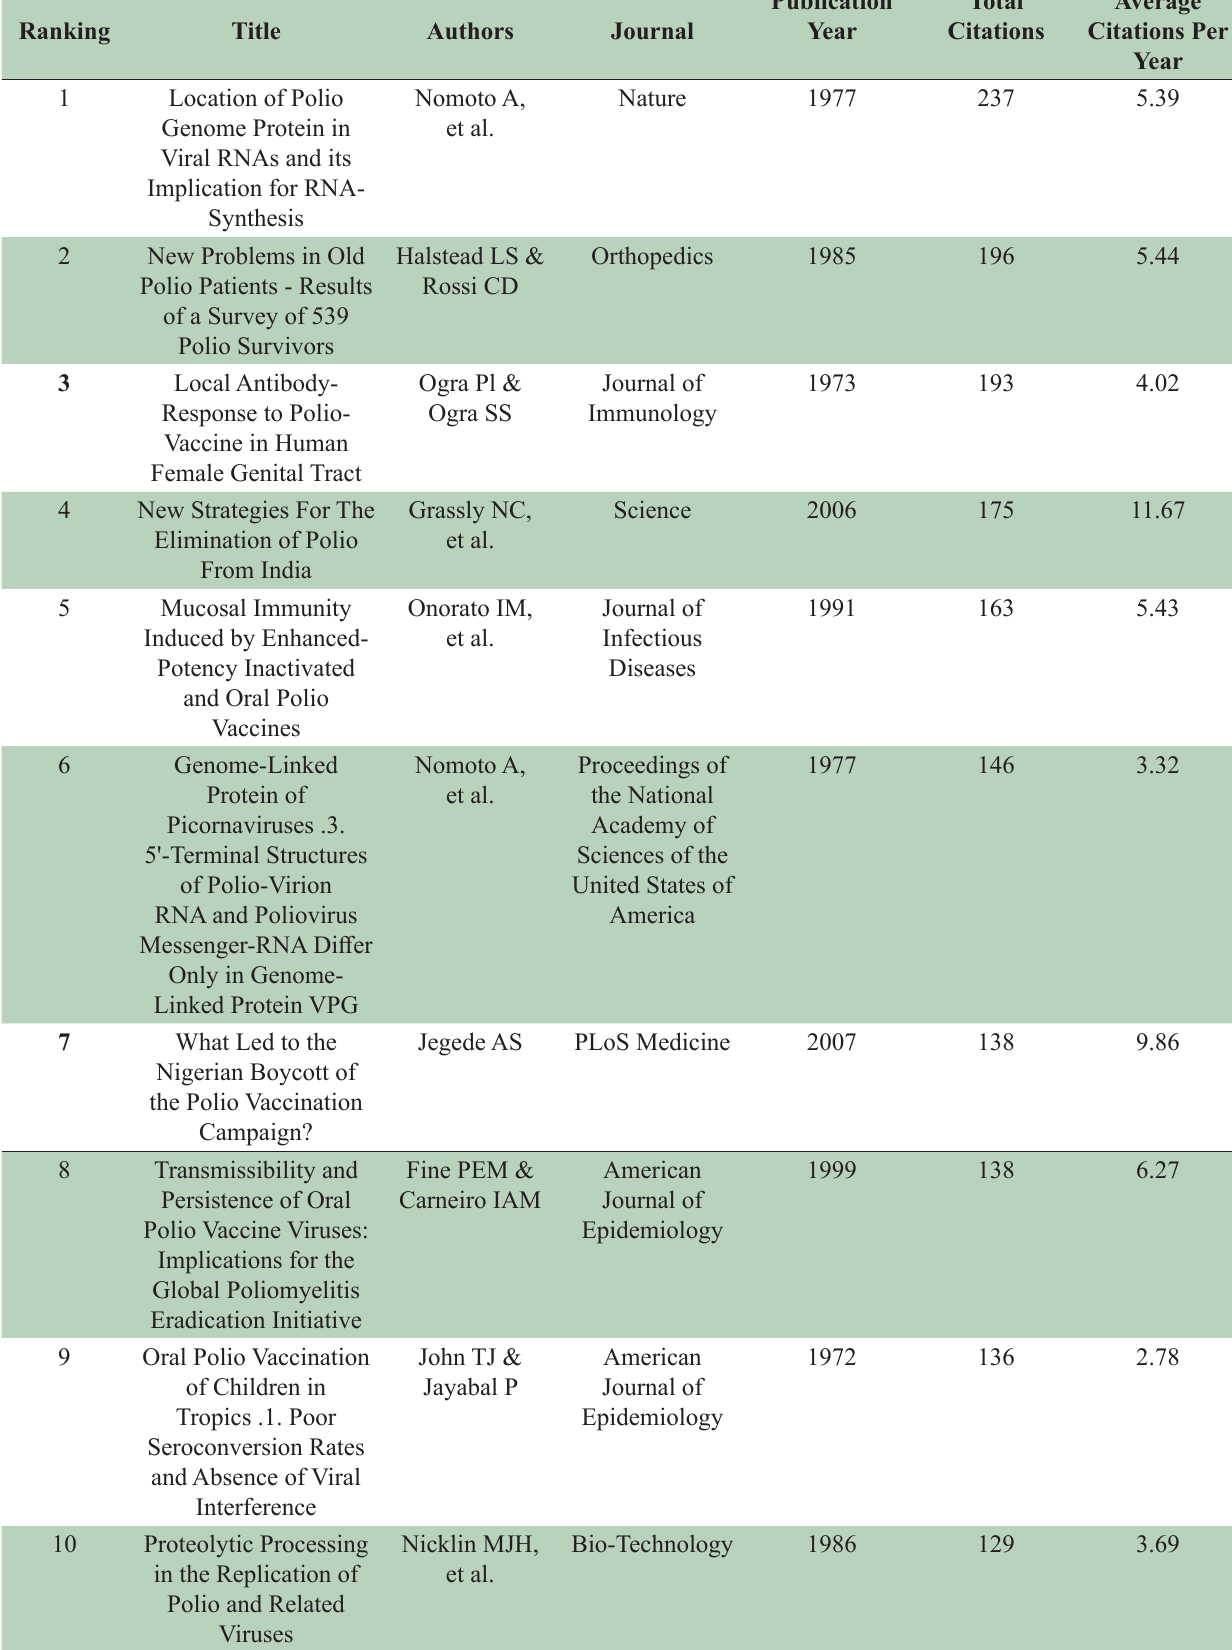
Table-I: Top ten most cited publications in polio